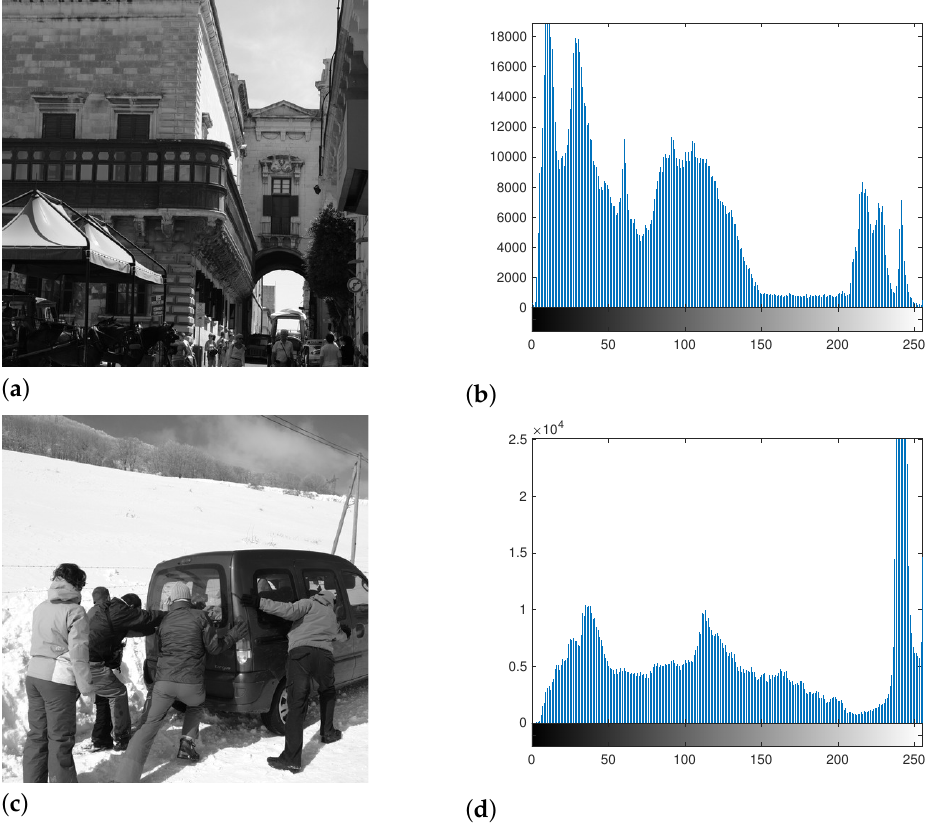
Figure 1. Natural images (( a ) image N11 and ( c ) image N18)) and their distributions of pixel values (( b ) for image N11 and ( d ) for image N18). Both histograms have more than 2 peaks. The segmentation results using Otsu’s method and BR’s method are shown in Figure